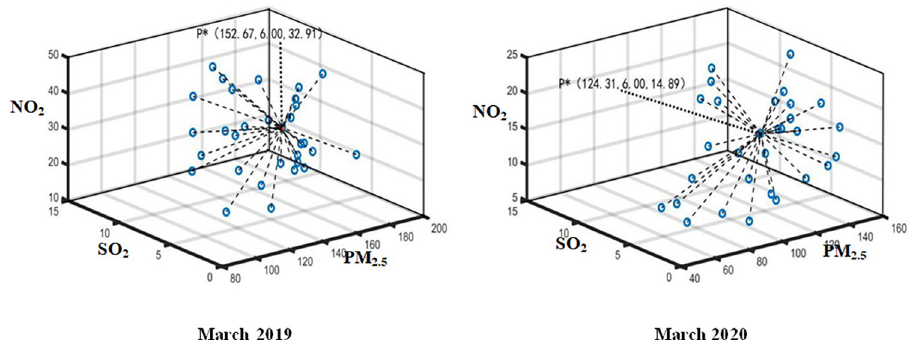
Fig 6. Aggregation result in March 2019 and